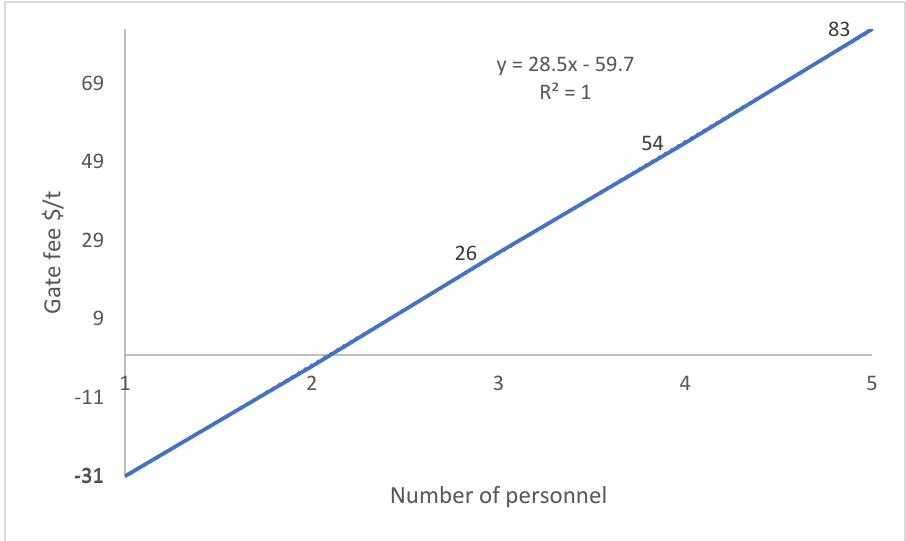
Figure 8. The effect of labor cost on the minimum gate fee for plastic waste.